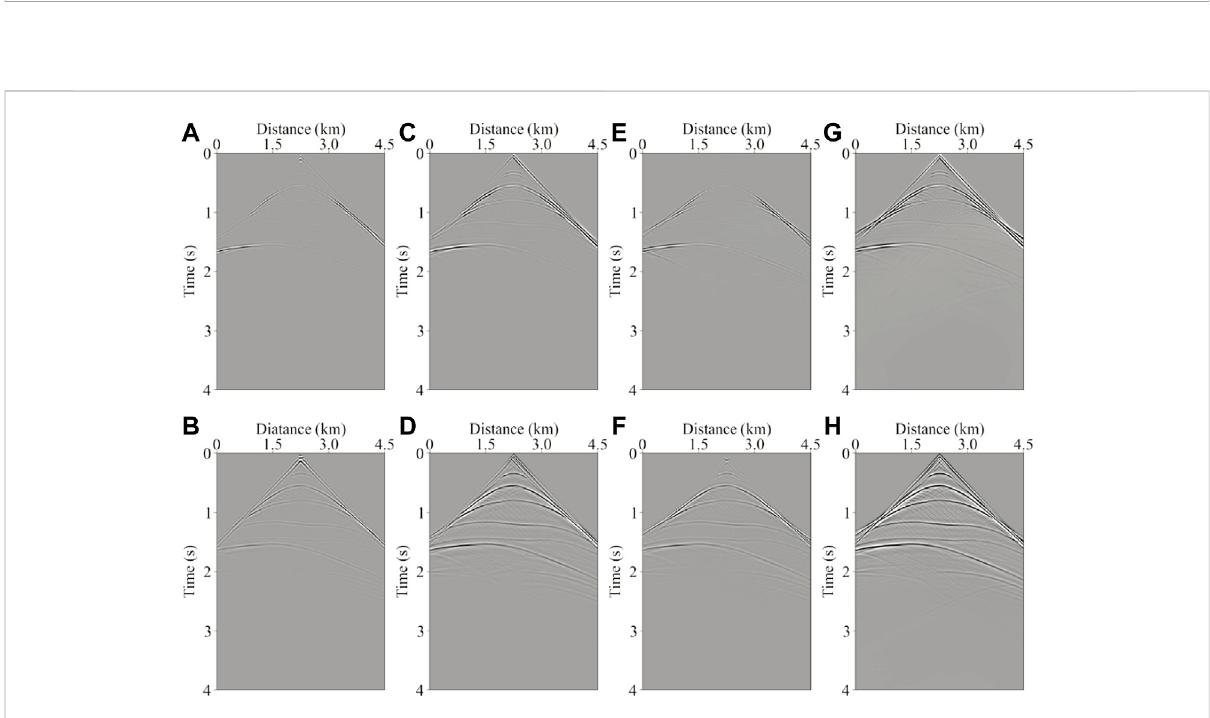
The 45th Born modeling common-shot gather of the Hess model. (A) RTM, (B) LSRTM, (C) viscoacoustic RTM, (D) viscoacousticLSRTM, (E) VTI RTM, (F) VTI LSRTM, (G) viscoacoustic VTI RTM, and (H) viscoacoustic VTI LSRTM. And the color scales of all the images are the